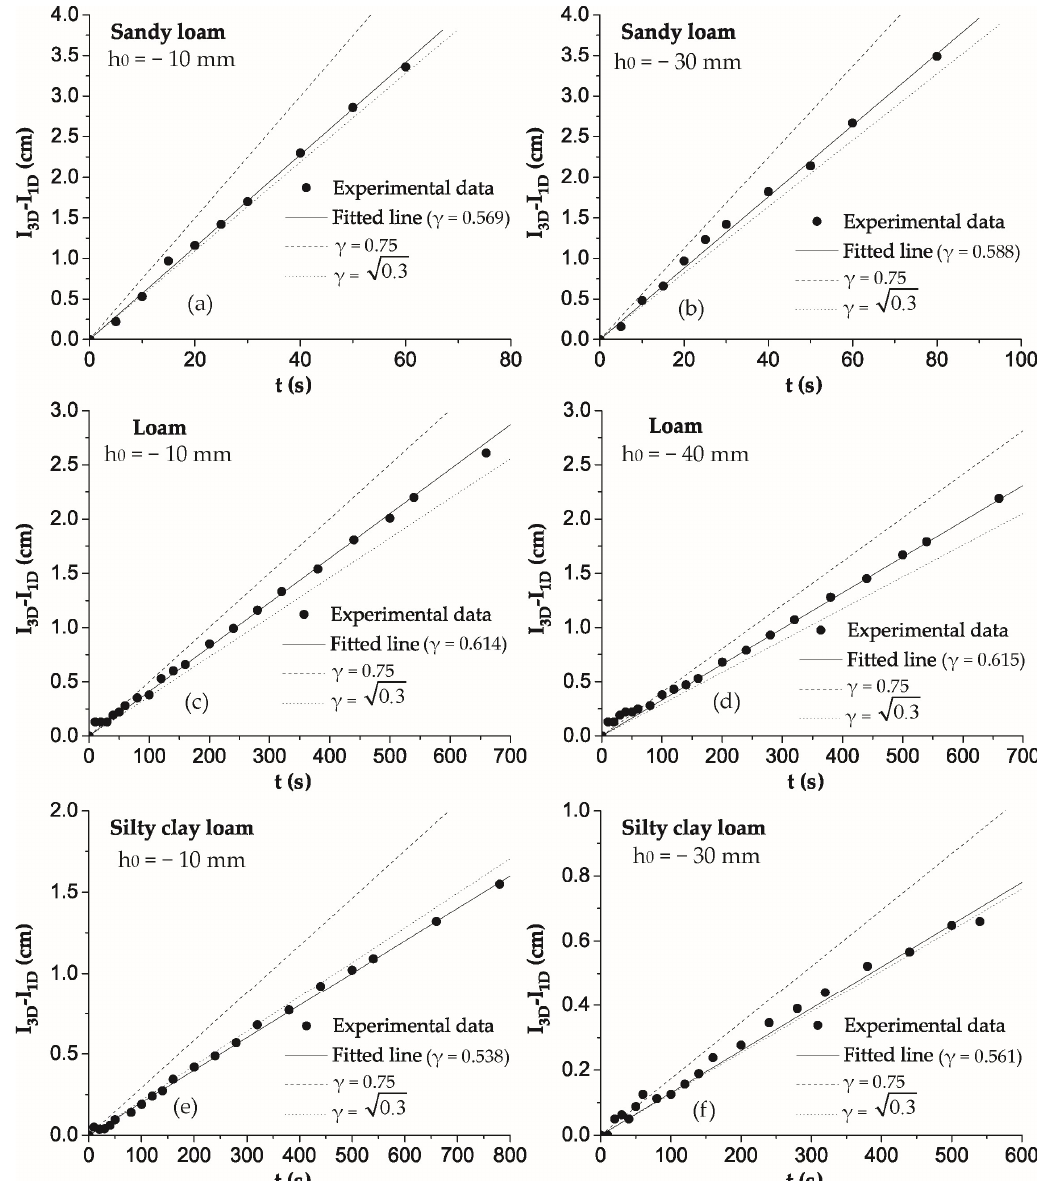
Figure 3. The difference between experimental three- and one-dimensional cumulative infiltration over time, for pressure heads: ( a ) h 0 = −10 mm and ( b ) h 0 = −30 mm for sandy loam soil; ( c ) h 0 = −10 mm and ( d ) h 0 = −40 mm for loam soil; and ( e ) h 0 = −10 mm and ( f ) h 0 = −30 mm for silty clay loam soil. The experimental γ value was calculated from the slope of the fitted line (solid line) using Equation (1). The model lines are derived from Equation (1) using two different values of γ: (i) 0.3 (dotted line) and (ii) 0.75 (dashed line).